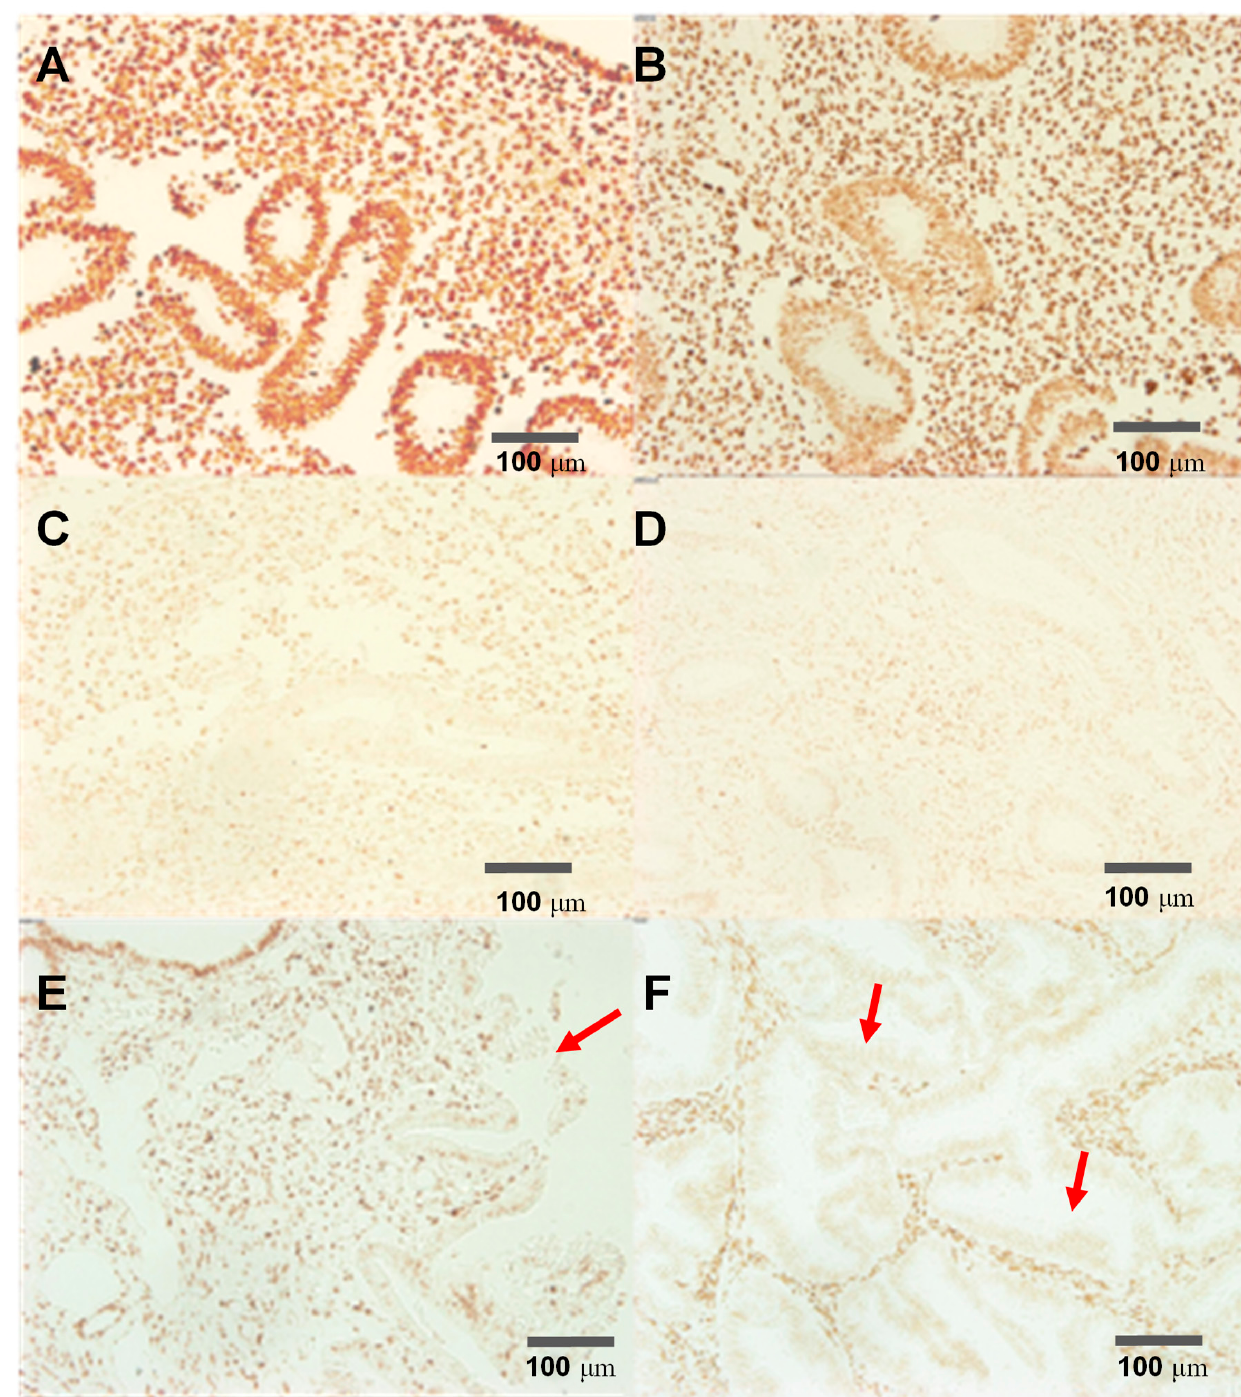
Figure 2. The PTENz7-87-biotin aptamer recognizes specifically the PTEN protein in human endometrial tissue. Endometrial samples were subjected to antigen retrieval and DNAse treatment and stained. ( A ) Control: Normal endometrial tissue stained using PTENz7-87-biotin and developed with avidin peroxidase; ( B ) Normal endometrial tissue stained using MAb 6H2 mouse monoclonal antibody; ( C ) Normal endometrial tissue stained using PTENz7-87-biotin competed with 5 µM of peptide; ( D ) Normal endometrial tissue stained using PTENz7-87-biotin competed with 2 mM GST-PTEN recombinant protein. ( E ) Hyperplastic tissue stained using PTENz7-87-biotin. The arrow shows an area with partial loss of PTEN stain in the adenoid. ( F ) Adenocarcinoma tissue stained using PTENz7-87-biotin. The arrows show examples of areas with loss of PTEN stain in all adenoids. Scale bars represent 100 µm.